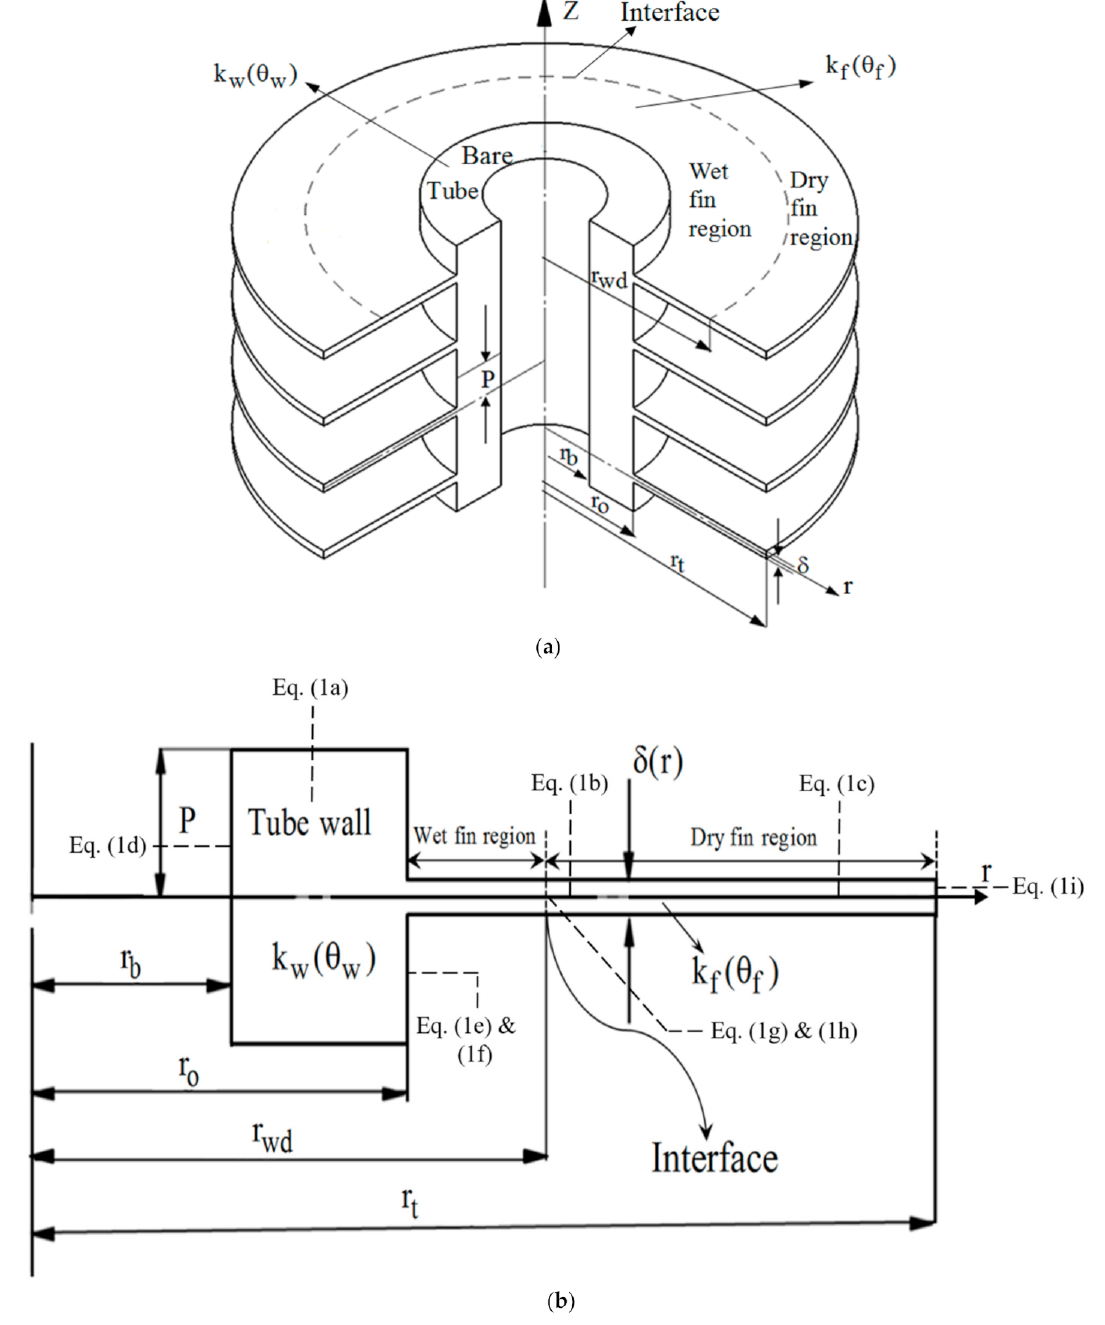
Figure 1. ( a ) A three-dimensional geometry of partially wet annular fins. ( b ) A cross-sectional view of a single annular